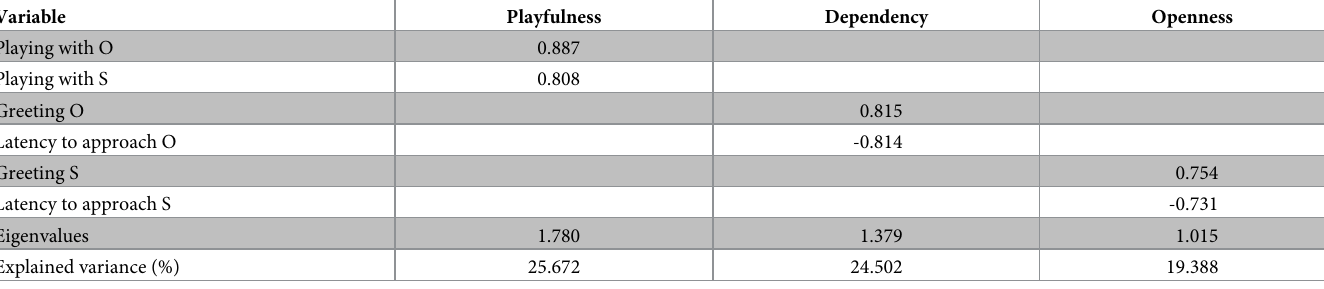
Table 8. Components derived from PCA on the variables measured in the greeting and playing subtest.